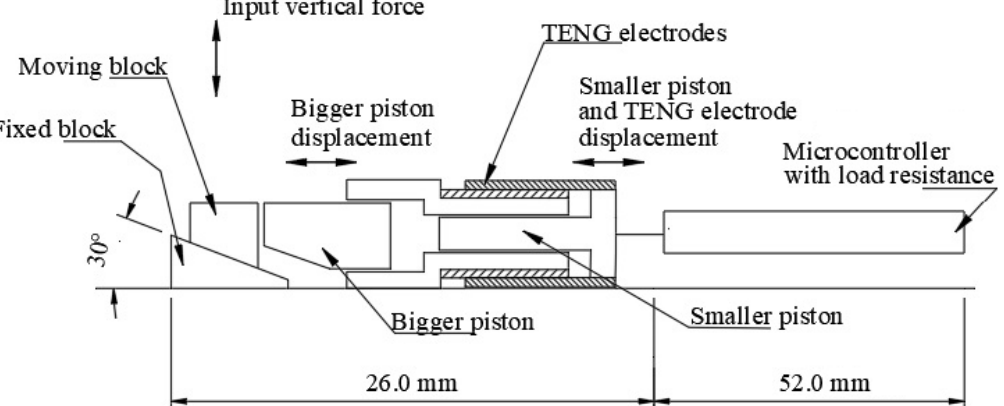
Figure 19. Arrangement in the self-powered in-shoe sensor.